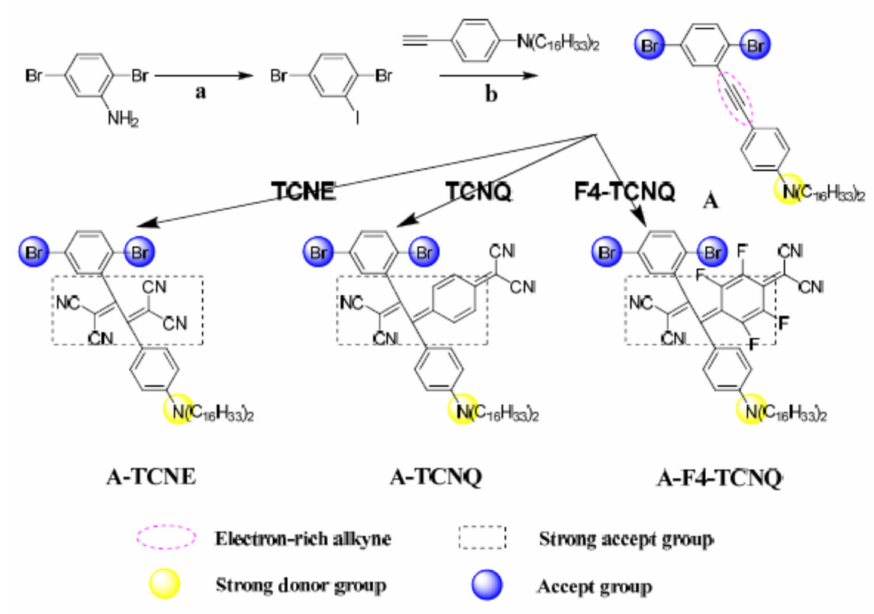
Figure 1. Synthesis routes of click compounds: ( a ) NaNO 2 , KI, HCl/H 2 O; ( b ) Pd(PPh 3 ) 4 , CuI, Et 3 N/THF, rt.